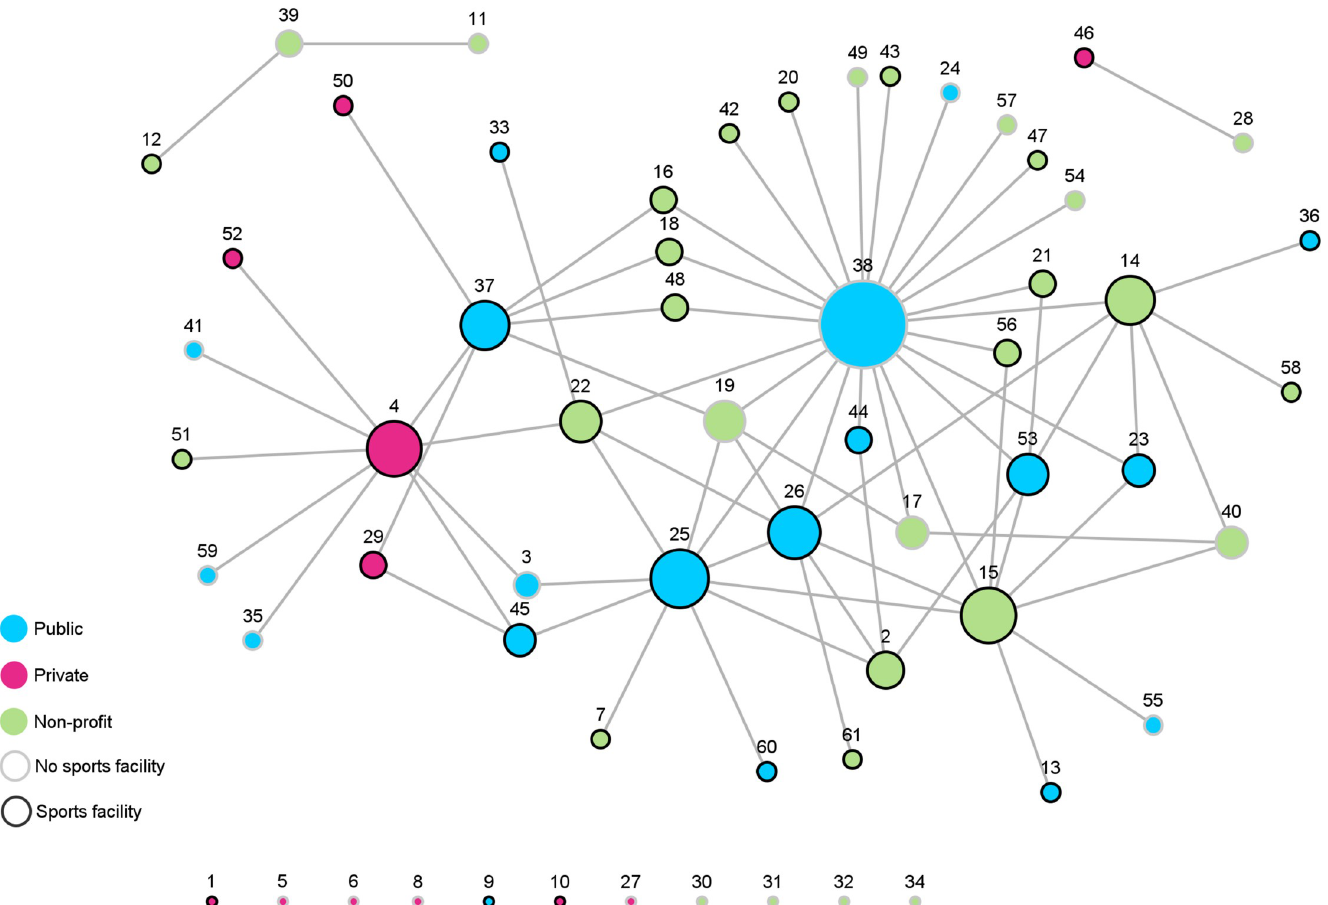
Fig 2. Visualization of the PAP network of cooperation ( n = 61). Ties between nodes indicate cooperation, node color represents sector affiliation, node boarder color represents possession of sports facility, node size represents degree centrality score (number of collaborative ties to other organizations).